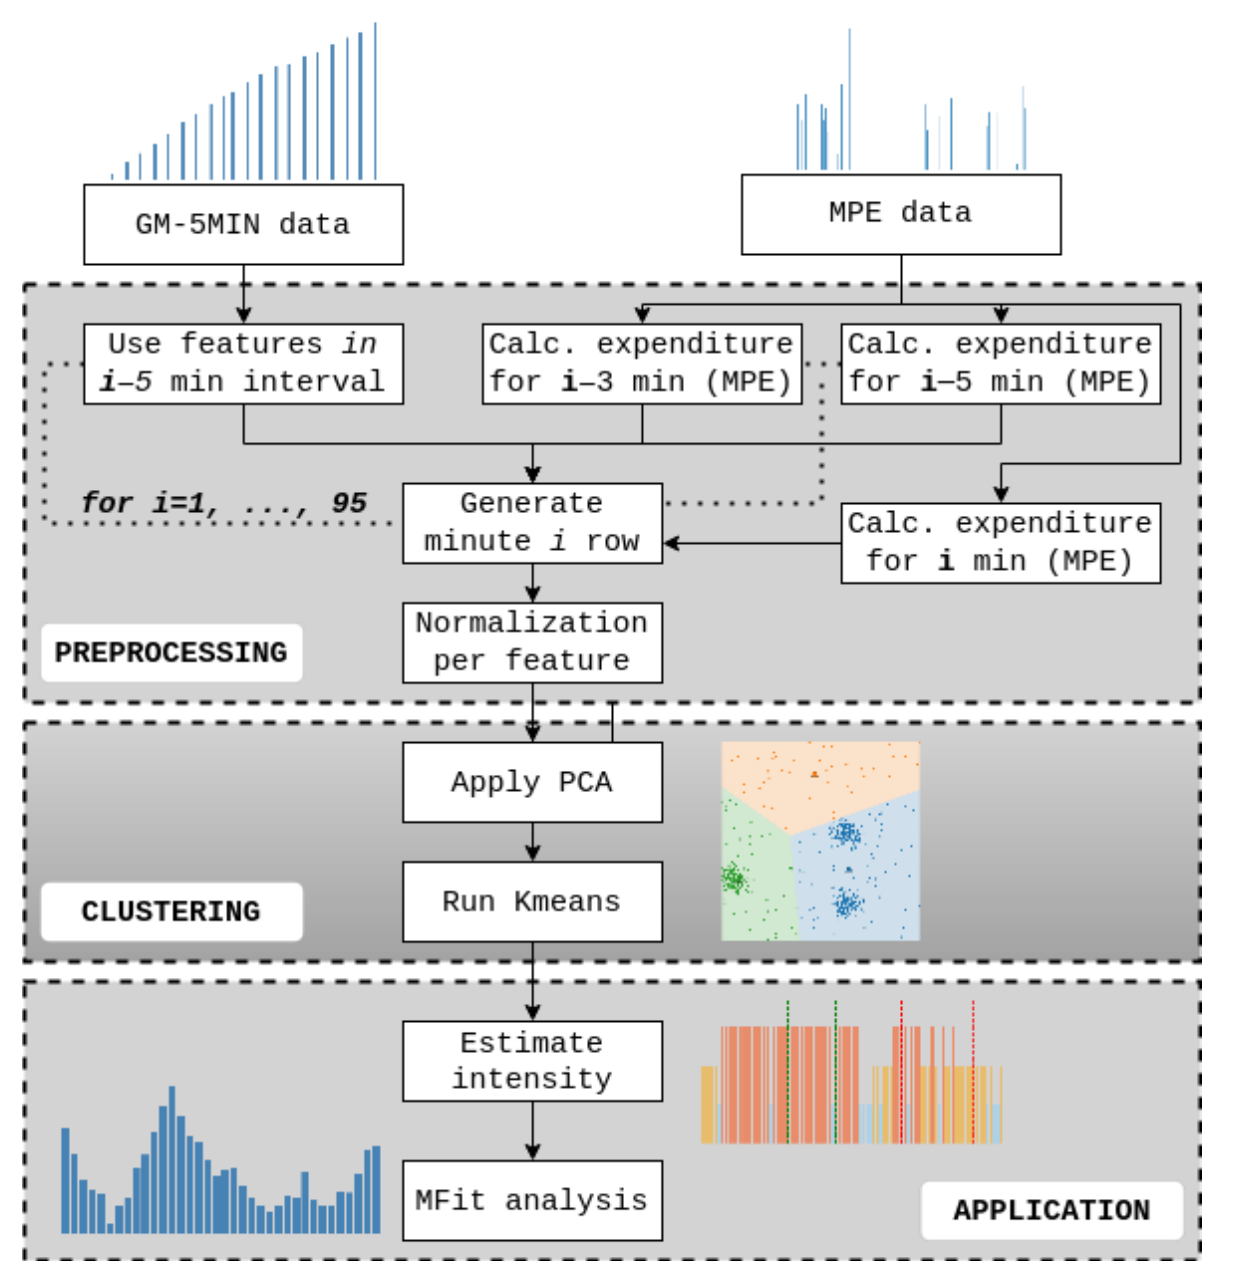
Figure 5. Preprocessing and clustering flowchart is divided into 3 parts. The first step shows how GM-5MIN-PRIOR, MPE-PRIOR, and MPE-CURRENT are combined. Next, dimensionality reduction using PCA is performed to prepare the data for K-means clustering. The final step consists of using the clustering algorithm to obtain low-, middle-, and high-intensity events throughout the game and to perform MFit analysis on the